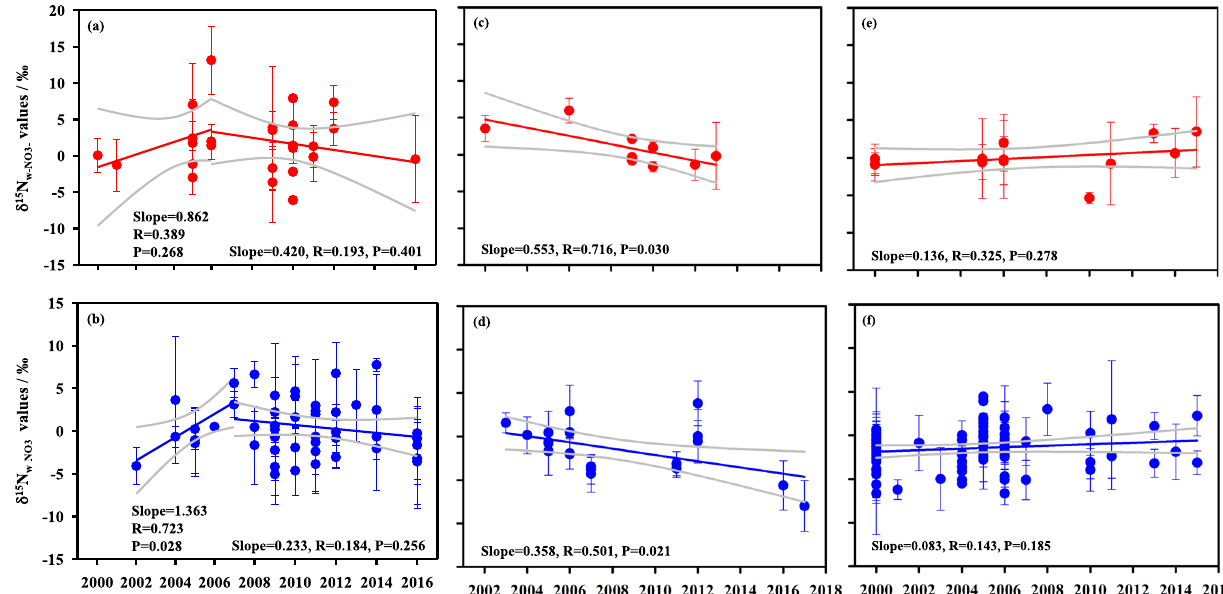
Fig. 3 Variations of δ 15 N w-NO3 − values during 2000 – 2017. a , b Urban and non-urban sites of East Asia. c , d Urban and non-urban sites of Europe. e , f Urban and non-urban sites of North America. Mean values of replicate measurements at each site in each year are shown. The gray lines are the 95% con fi dence intervals.